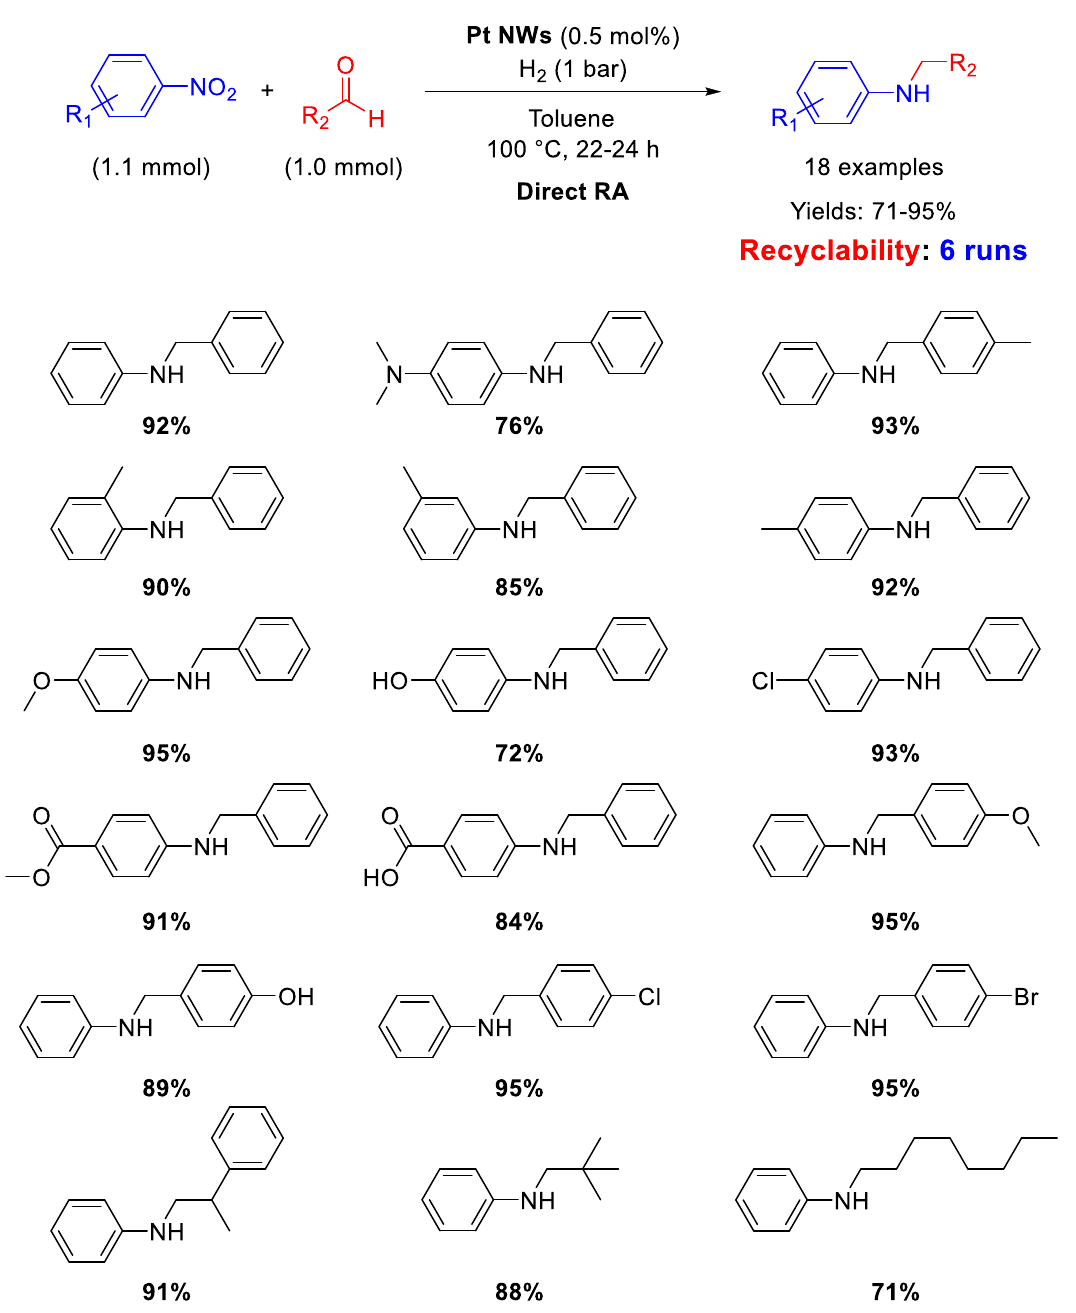
Scheme 22. DRA catalyzed by Pt